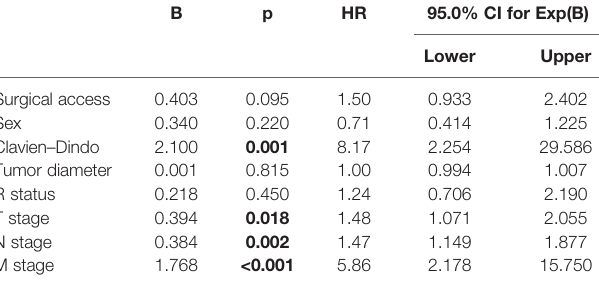
TABLE 4 | Multivariate Cox regression model.